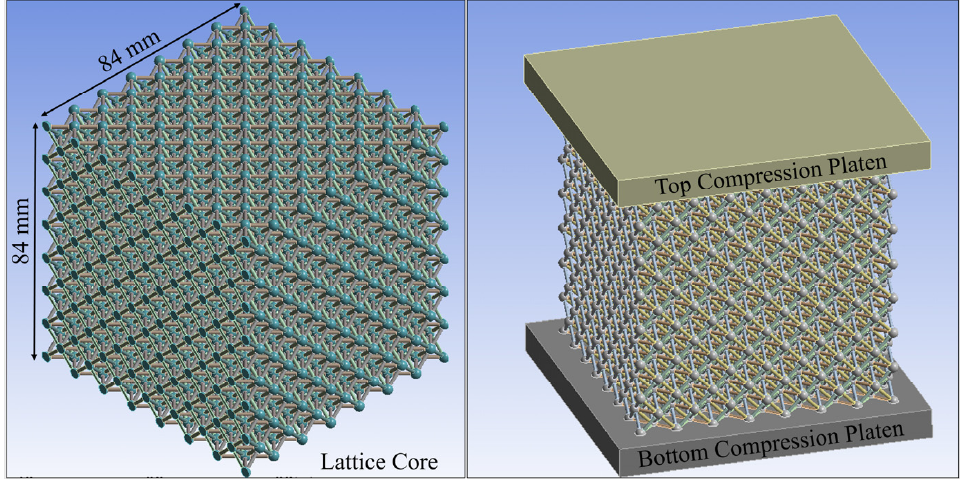
Figure 9. Digital twin of a 7 × 7 × 7 octet truss compressive test setup ( Left ) without compression testing plates, and ( Right ) with compression loading plates.